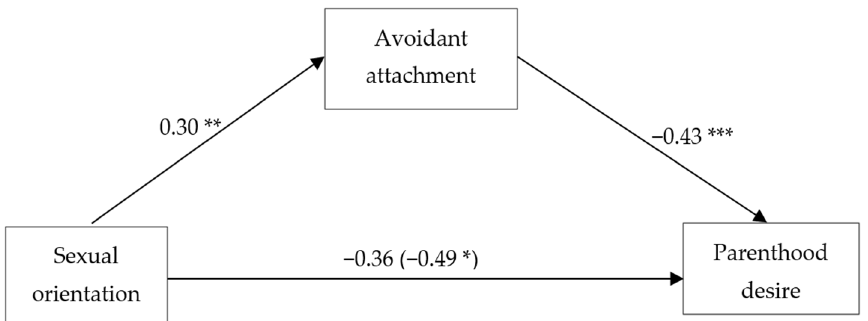
Figure 1. The mediation effect of avoidant attachment on the association between sexual orientation and parenthood desire. Note. N = 789. The reported values are unstandardized regression coefficients ( B s) for the pathways between sexual orientation (0 = heterosexual, 1 = sexual minority), avoidant attachment, and parenthood desire. Gender, age, education, relationship status, and place of residence were used as covariates. The total effect of sexual orientation on parenthood desire is reported in parentheses. * p < 0.05. ** p < 0.01. *** p < 0.001.